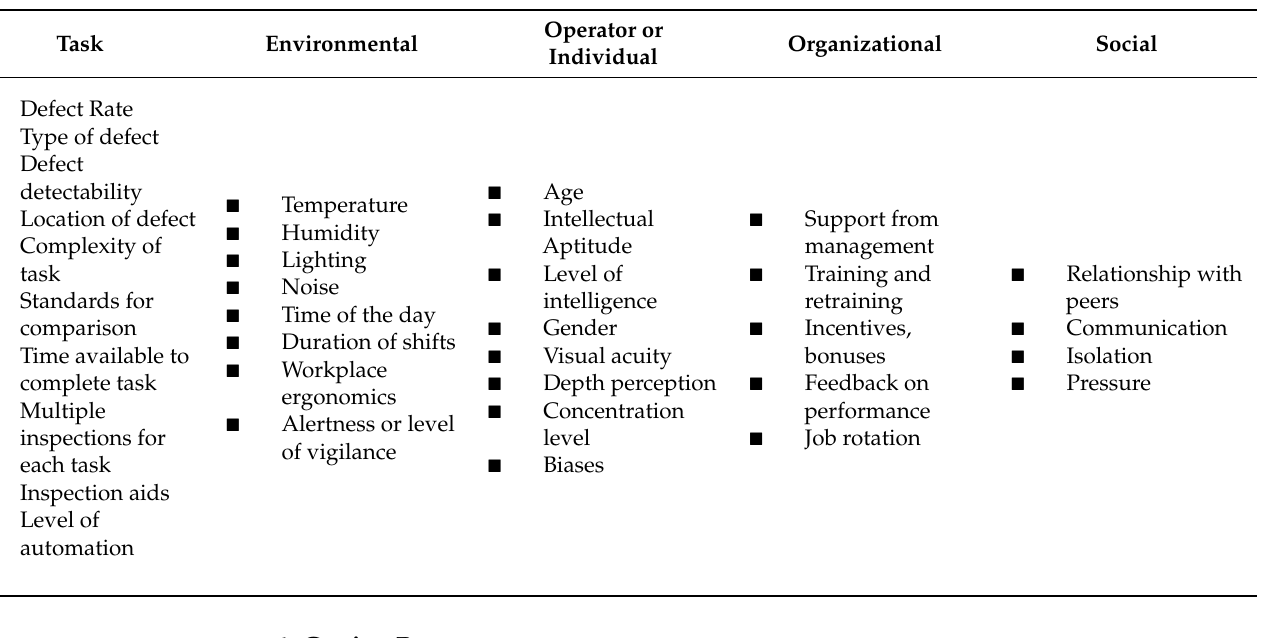
Table 1. Factors that affect visual